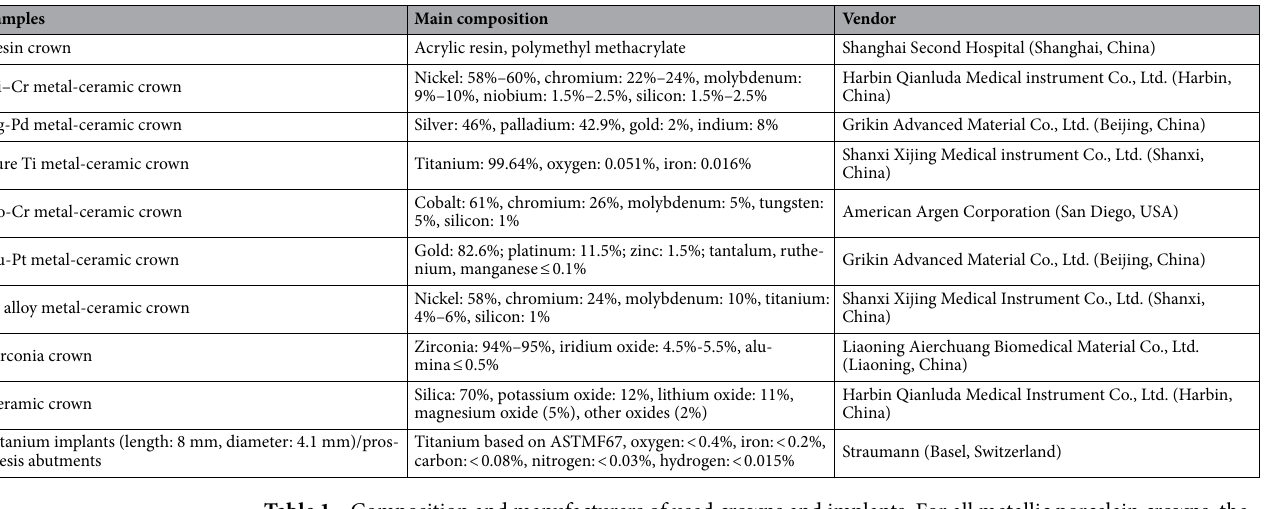
Table 1. Composition and manufacturers of used crowns and implants. For all metallic porcelain crowns, the components above only include the metallic parts, and their porcelain parts were composed of silicon